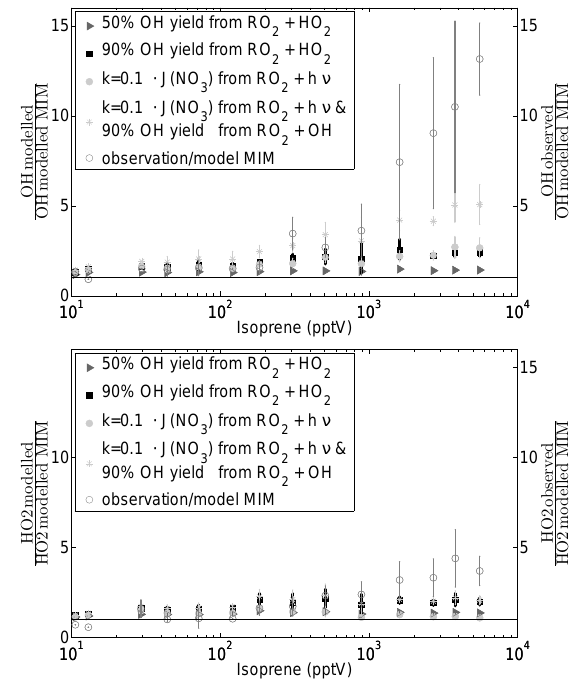
Fig. 14. Comparison of observed and modelled HO x based on selected changes in the MECCA chemistry scheme. Values are binned in isoprene mixing ratios (x) of ∆ln x = 0 . 5 .